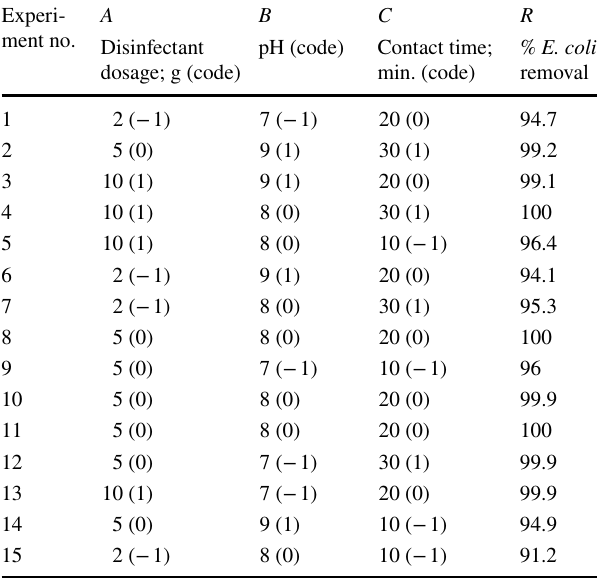
Table 2 The Box–Behnken design matrix with three independent var- iables ( A , B and C ) A Experi- ment no.